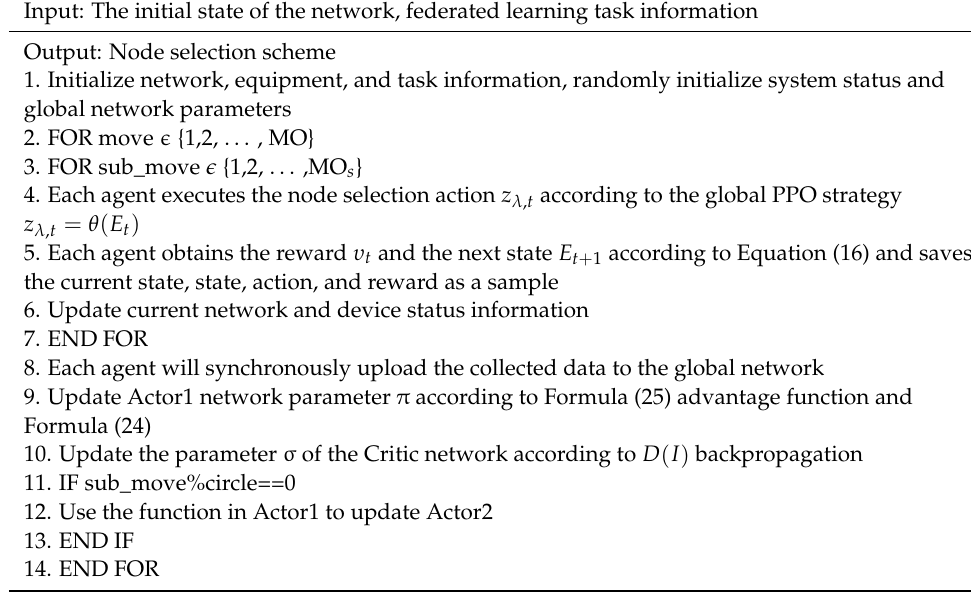
Algorithm 1. FABD, FL node selection algorithm based on DPPO in IOT